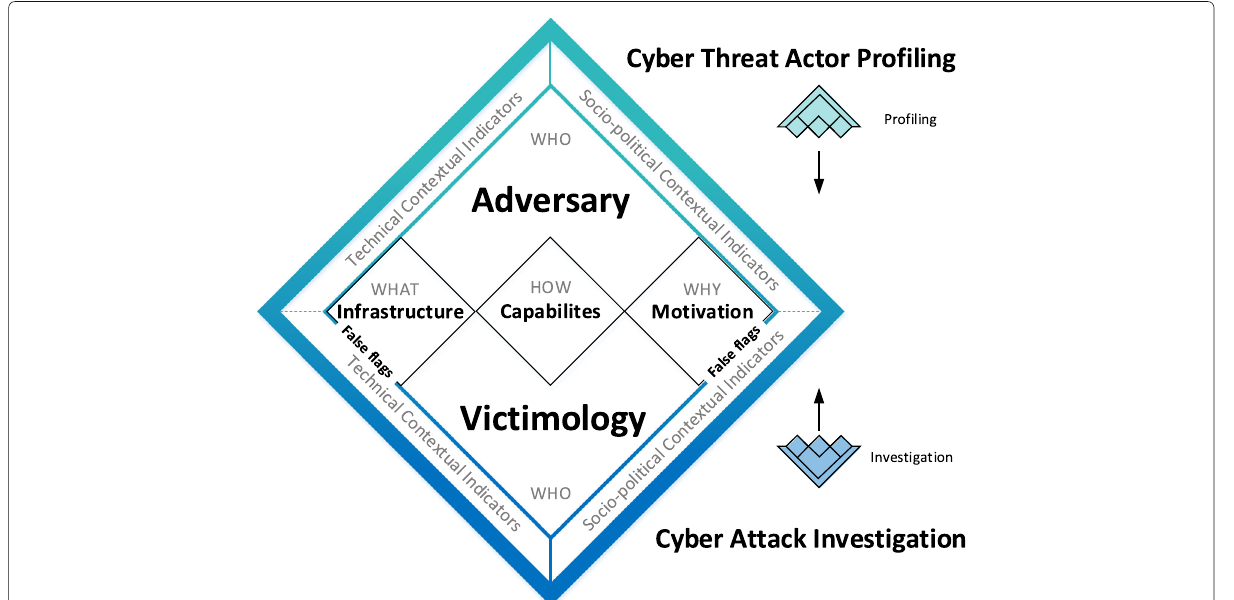
Fig. 2 The Cyber Attribution Model applied to detect inconsistencies in the attribution process